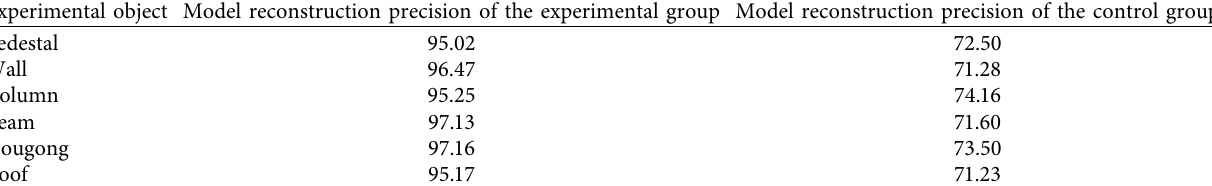
Table 2: Comparison of experimental data